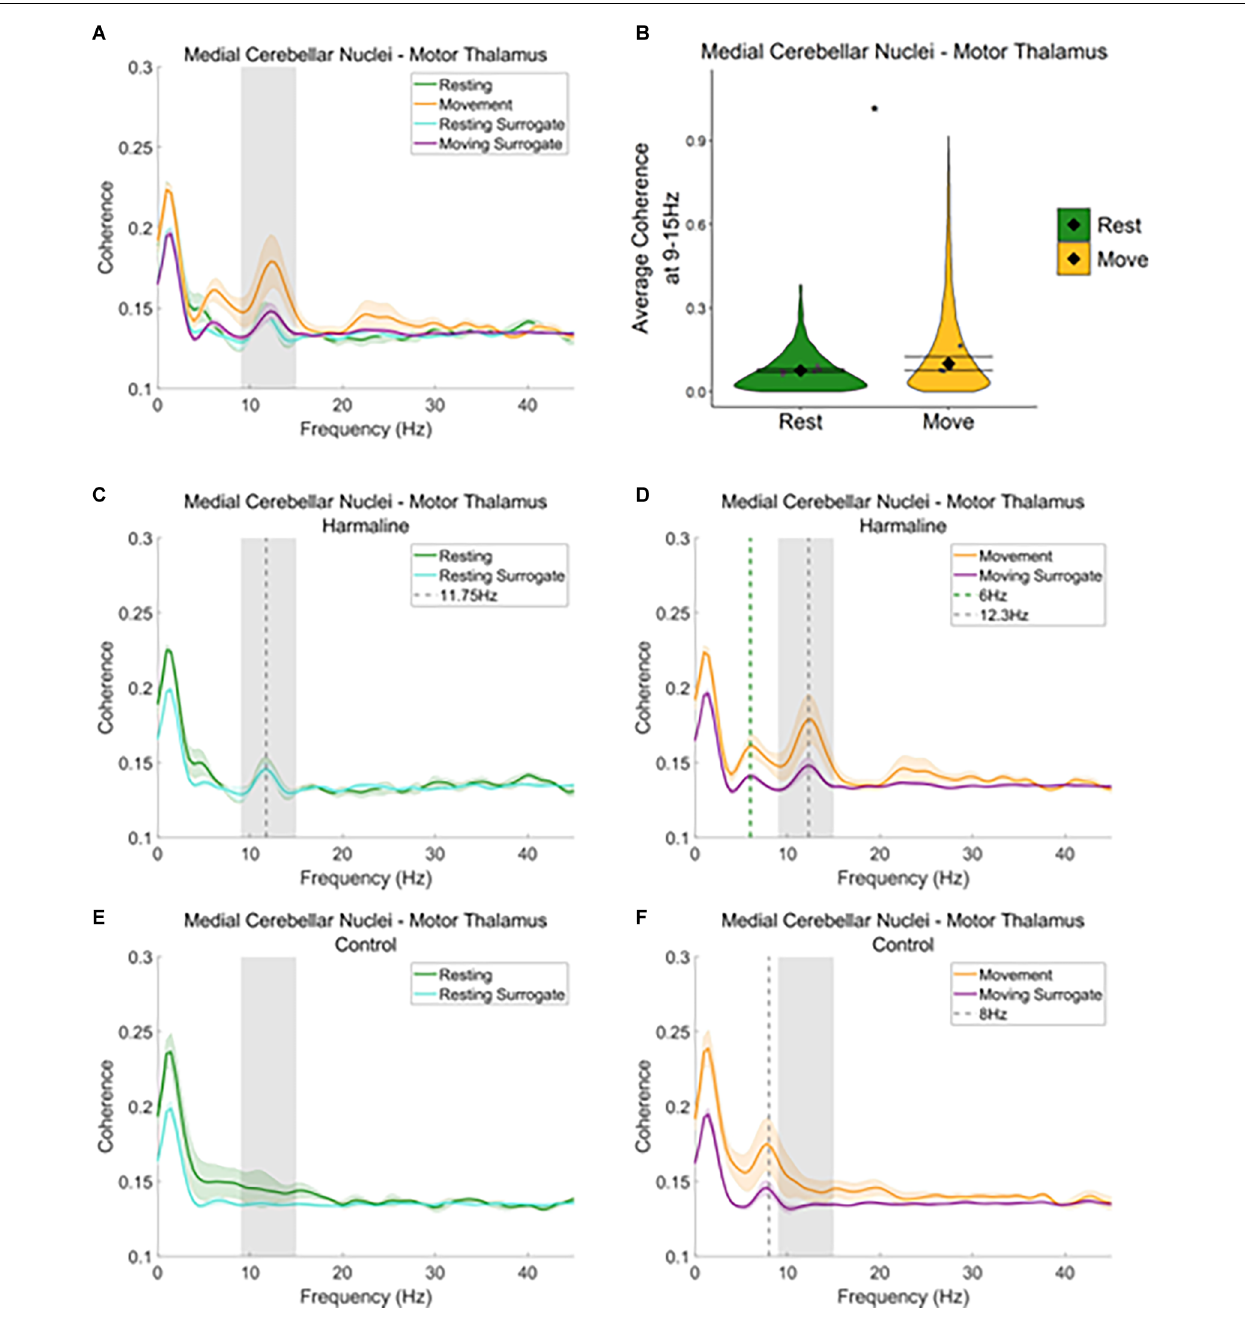
FIGURE 6 | Cerebello-thalamic coherence in the harmaline model. (A) Mean ( ± SE) (A) cerebellar nuclei-thalamic ( n = 6) coherence during resting and movement for real and surrogate datasets. The solid line represents mean coherence, and the coloured shaded areas represent SE. The grey area represents the tremor frequency. (B) Average surrogate-corrected cerebellar nuclei-thalamic coherence at the tremor peak across all epochs with significant coherence (pooled across rats). Individual grey points represent the mean per rat. Fixed effects parameter estimates ( ± CI) representing predicted mean estimates are shown by (cid:7) and corresponding error bars. ∗ indicates p < 0.05. (C–F) Mean ( ± SE) cerebellar nuclei-thalamic ( n = 6); coherence in harmaline model (C,D) and control (E,F) during resting (C,E) and movement (D,F) for real and surrogate datasets. The solid line represents mean coherence, and the coloured shaded areas represent SE. The grey area represents the tremor